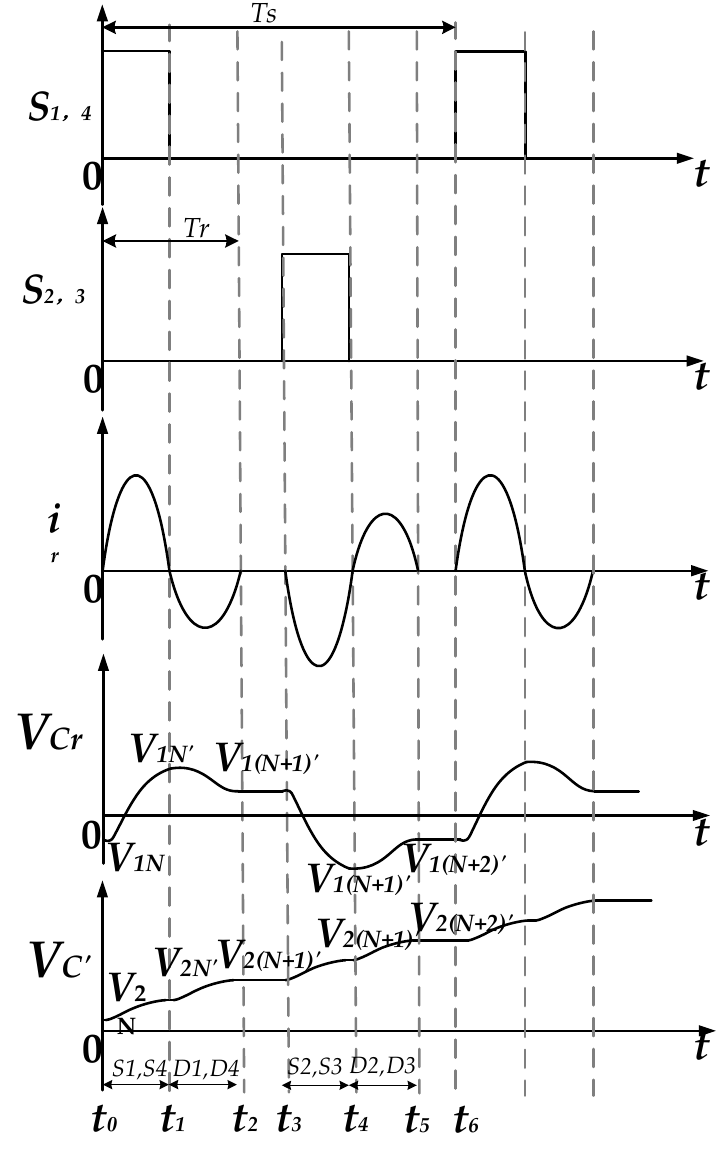
Figure 3. The waveform of series resonant circuit in DCM.